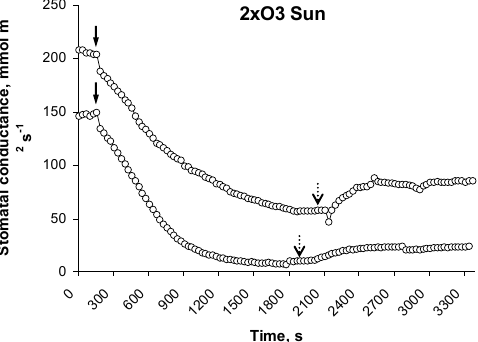
Figure 5. Examples of unresponsive 2xO 3 beech leaves. Stomata closed regularly when the light was off (full arrows) but did not re-open when the light was on (dotted arrows).